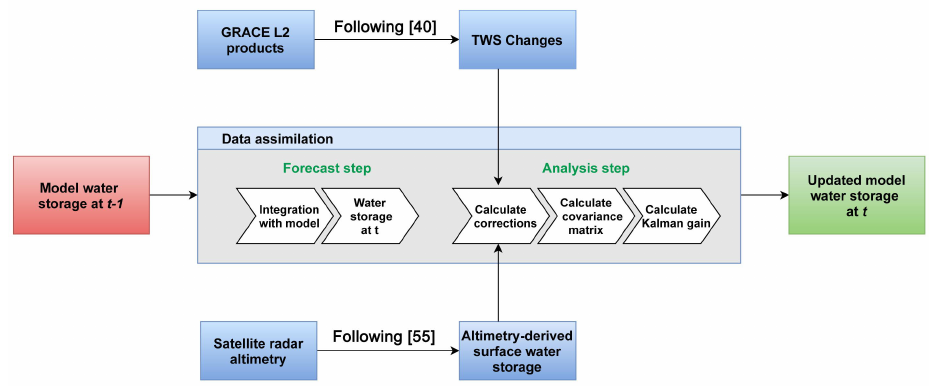
Figure 2. The implemented data assimilation scheme to integrate GRACE TWS and altimetry-derived surface water storage with the